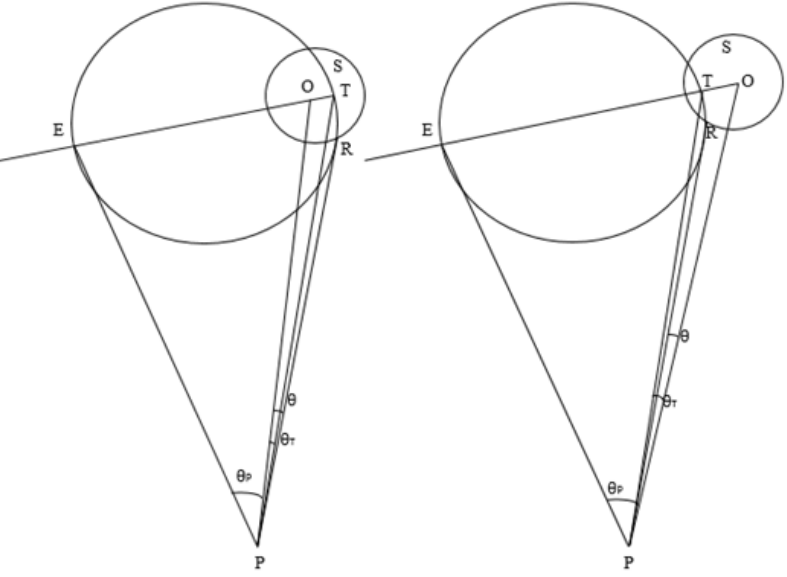
Figure 3. The intersection of reflected rays on the receiver reference plane: the area of circle S represents the receiver plane; point O is cross-point of the central solar ray on the receiver; right: O is in the area of the receiver; left: O is out of the receiver.